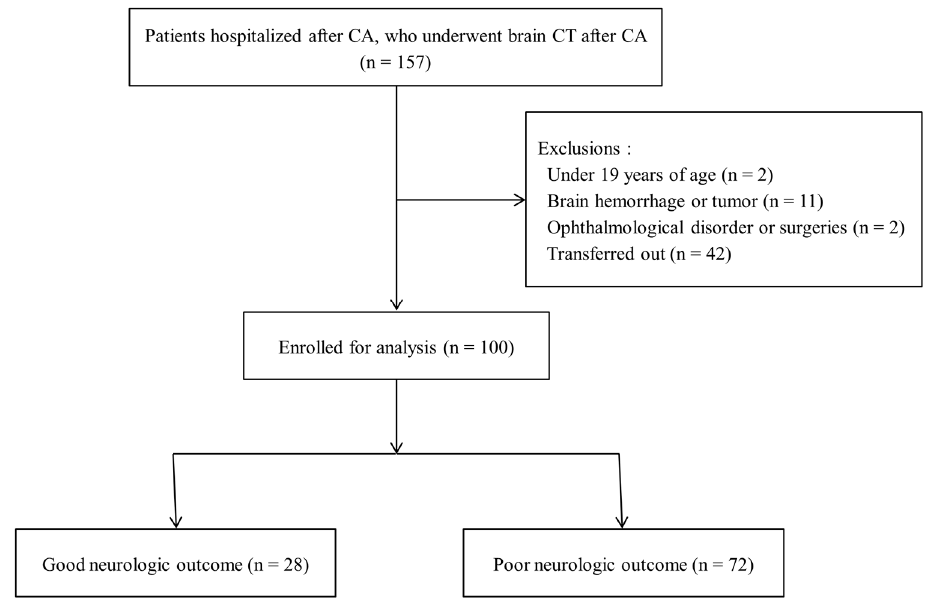
Figure 1. Flow chart of the study. Abbreviations: CA, cardiac arrest; CT, computed tomography. Table 1. Baseline characteristics and univariate analysis.